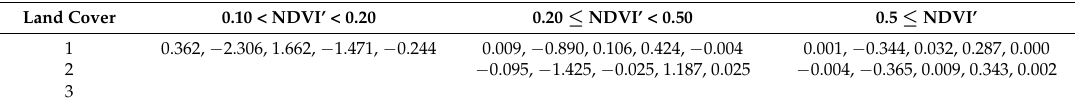
Table 4. Surface Reflectance Coefficients for 0.47 µ m for September-October-November (SON). Land Cover 0.10 < NDVI’ <